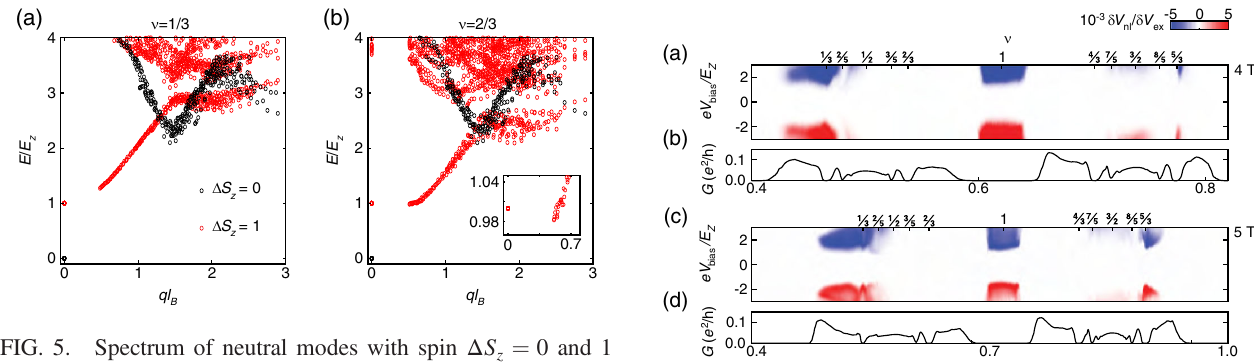
FIG. 5. Spectrum of neutral modes with spin Δ S measured relative to the ground state for ν ¼ (a) 1 = 3 and (b) 2 = 3 at B ⊥ ¼ 4 T calculated using exact-diagonalization techniques. Here q is the two-dimensional wave vector. l magnetic length. B is the perpendicular magnetic field.